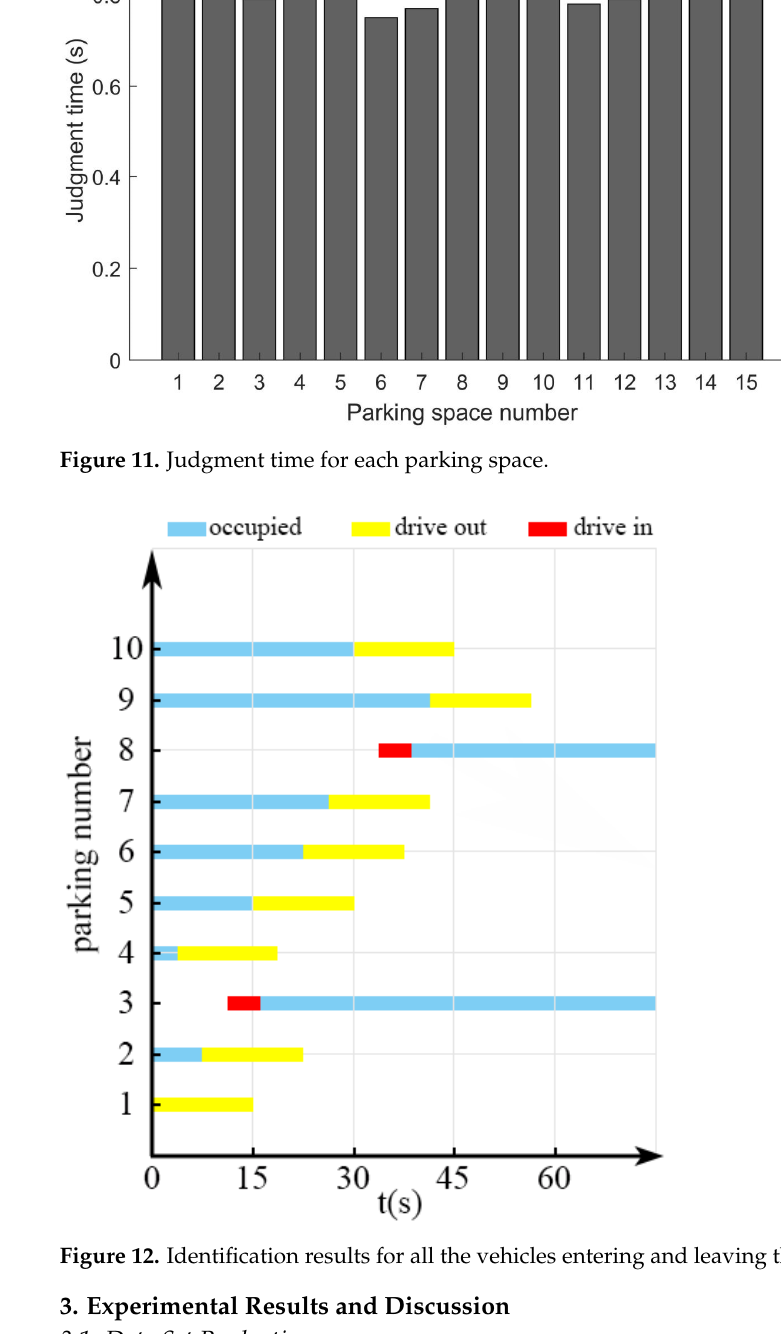
Figure 12. Identification results for all the vehicles entering and leaving the parking spaces.